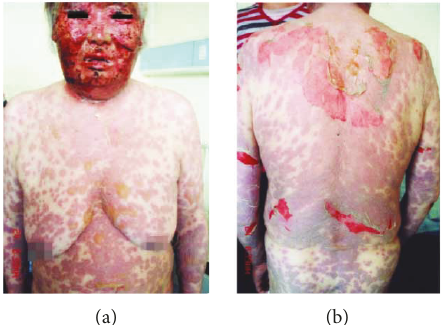
Figure 2: Typical cases of TEN from Chinese literature [12]. (a) Widespread reddish to purplish macules and bullae on the trunk and upper limbs, with erosions on swollen face. (b) Macules and large skin detachment on the lateral trunk and upper